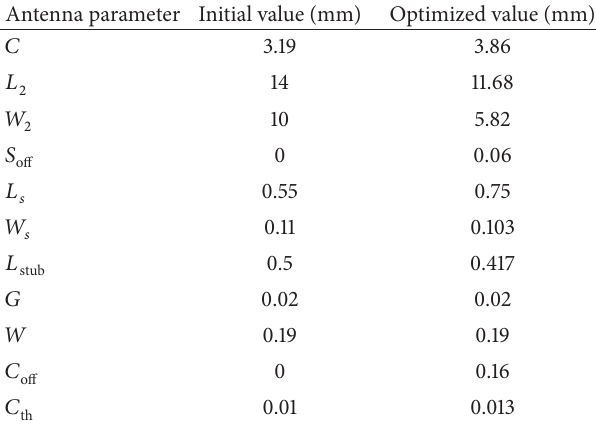
Table 1: Comparison of initial and final optimized design parame- ter.